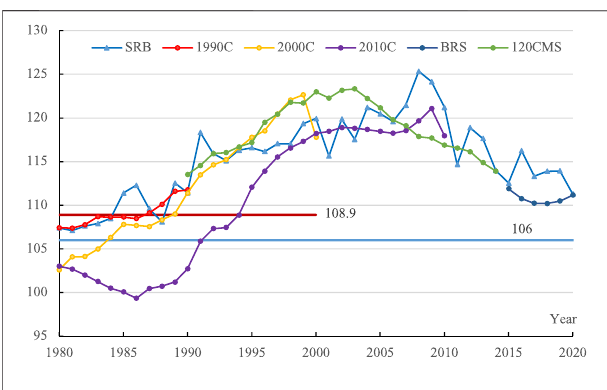
FIGURE 1 | SRB by comparison over